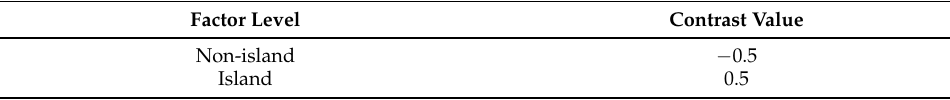
Table A12. Contrasts for Experiment 1 Structure factor.